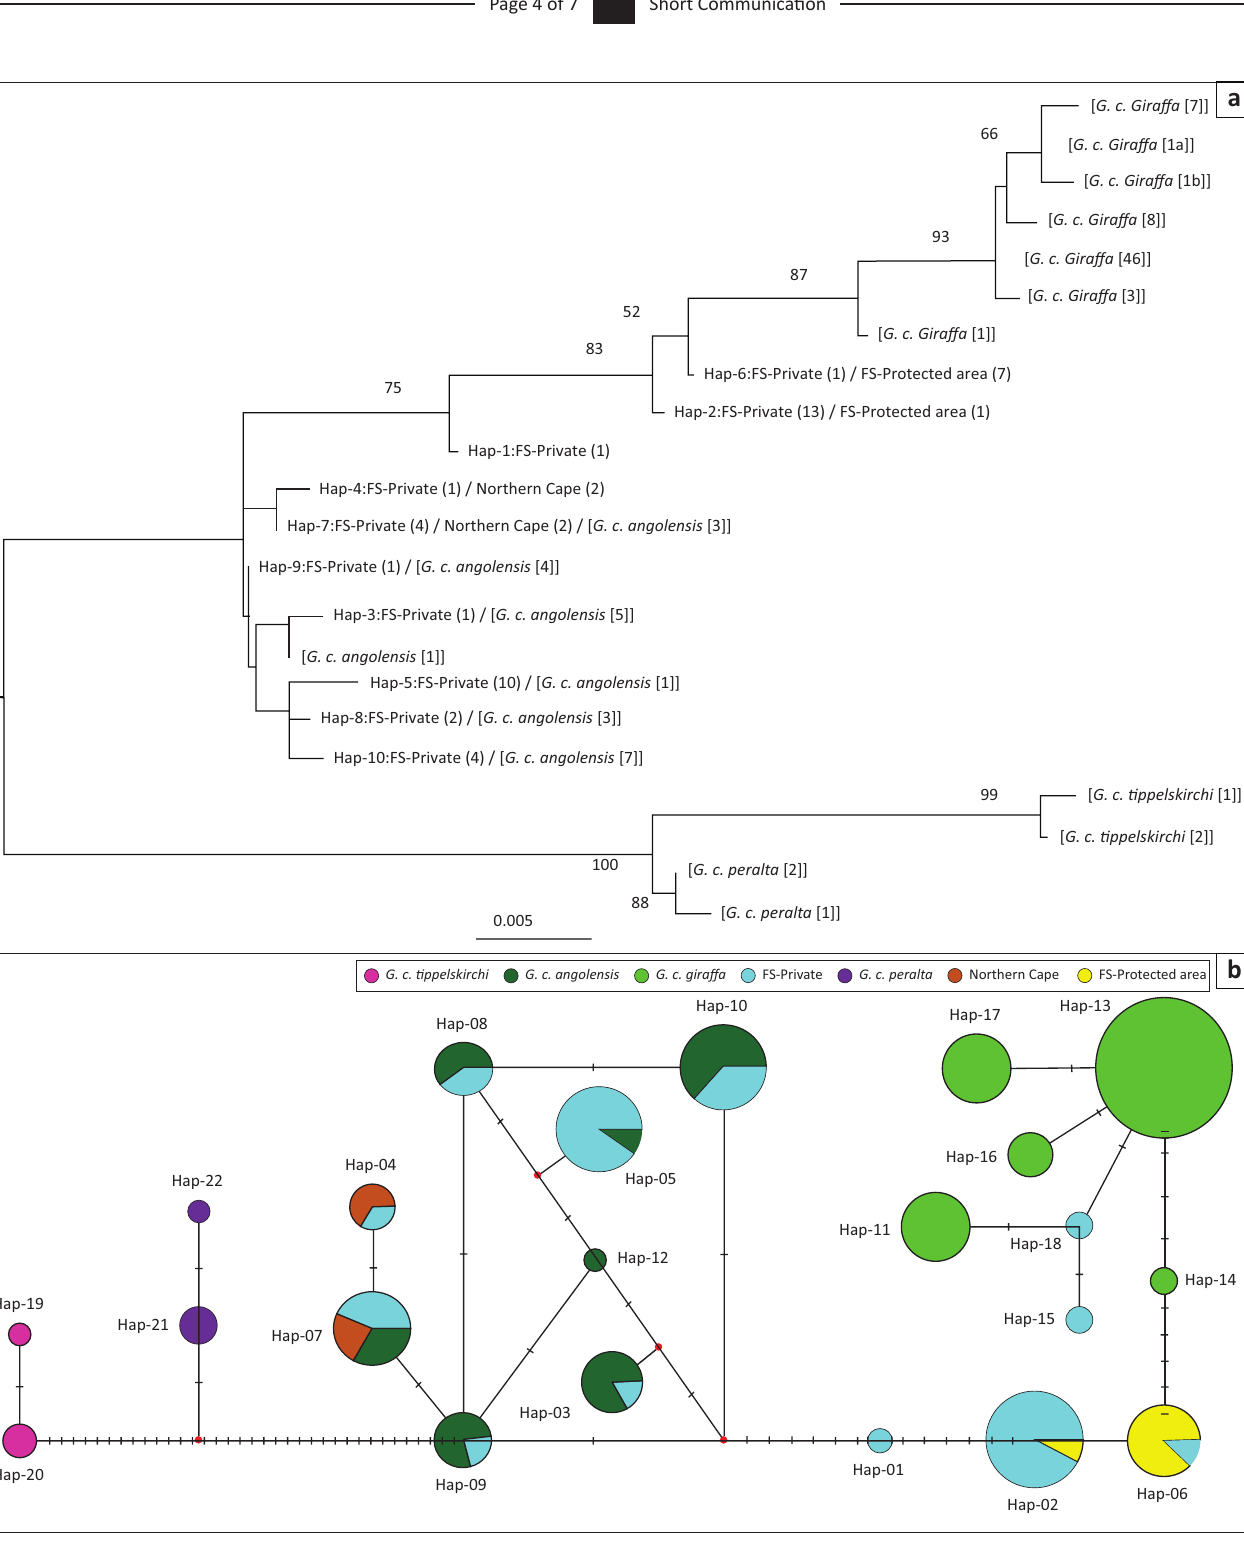
http://www.koedoe.co.za Open Access